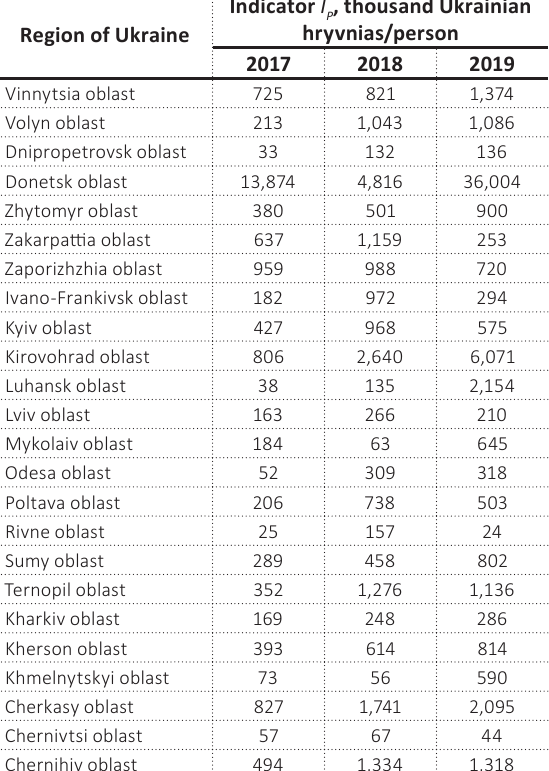
Table 2. Results of calculation of indicators I by regions of Ukraine, 2017‒2019